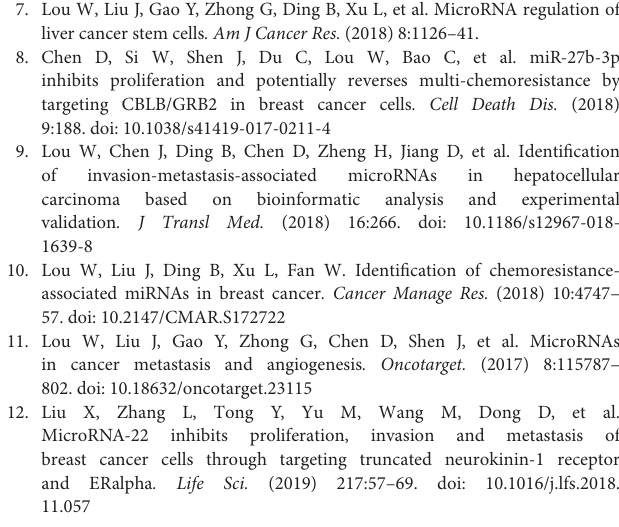
Figure S1 | The protein-protein interaction (PPI) network of candidate DE-mRNAs established by STRING database. Supplement 1 | The DE-miRNAs between luminal A and luminal B breast cancer. Supplement 2 | The De-mRNAs between luminal A and luminal B breast cancer. Supplement 3 | The potential target genes of DE-miRNAs. Supplement 4 | The 312 DE-mRNAs commonly appeared in the gene set of target genes of DE-miRNAs. Supplement 5 | The 72 potential miRNA-mRNA paris in ERa positive breast